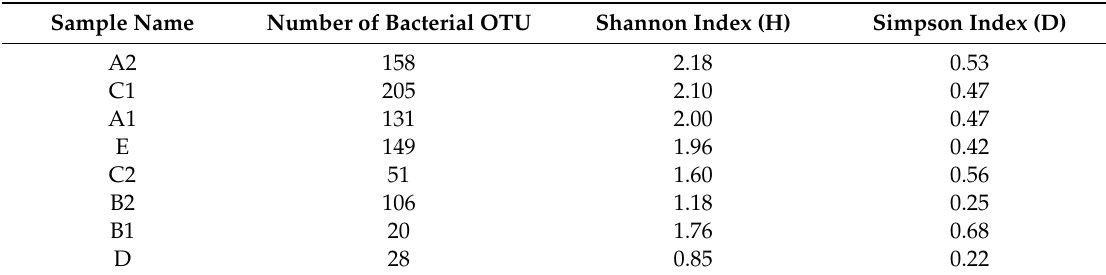
Table 2. Richness and diversity estimation of the bacterial community in honey from eight di ff